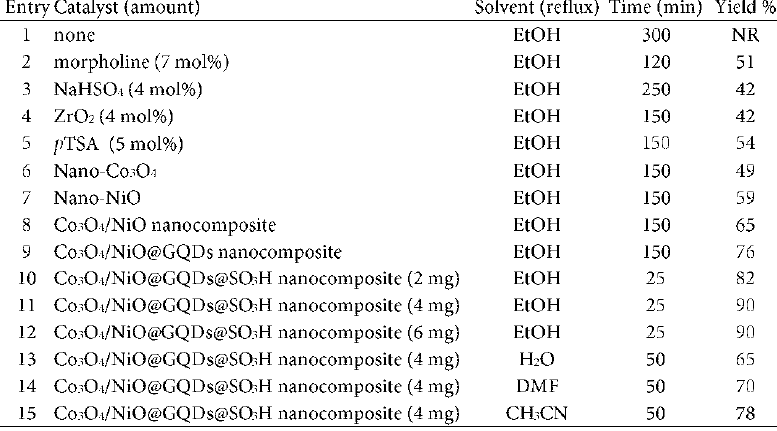
Table 1. Optimization of reaction condition using different catalysts a